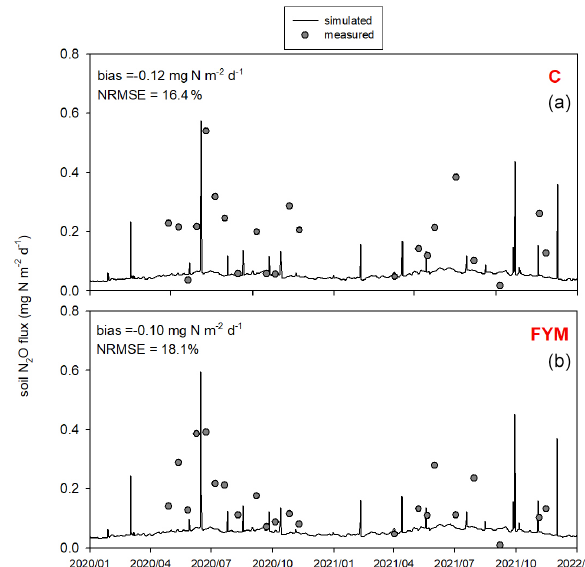
Figure 12. Comparison of the simulated and observed soil N 2 O ef- flux for two treatments: absolute control ( C; a) and application of farmyard manure ( FYM; b) between January 2020 and December 2021 at Martonvásár. Whiskers indicate the uncertainty ( ± 1 stan- dard deviation) of the measurements.